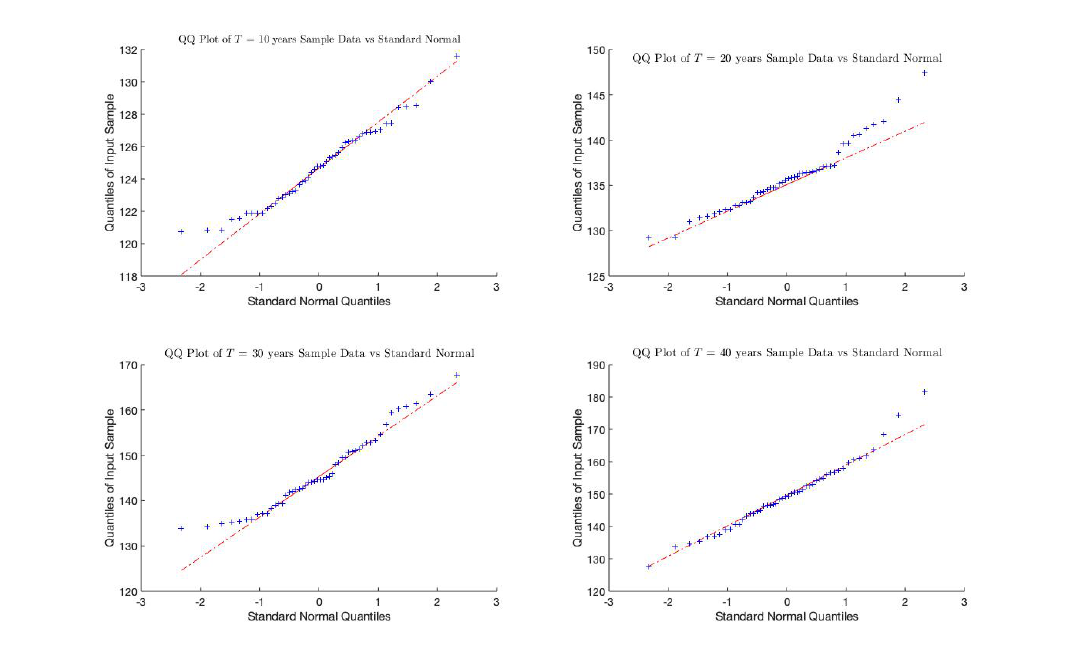
Figure 5. QQ-Plot between the unit-linked price input data and the standard normal distribution for maturities T = { 10,20,30,40 }